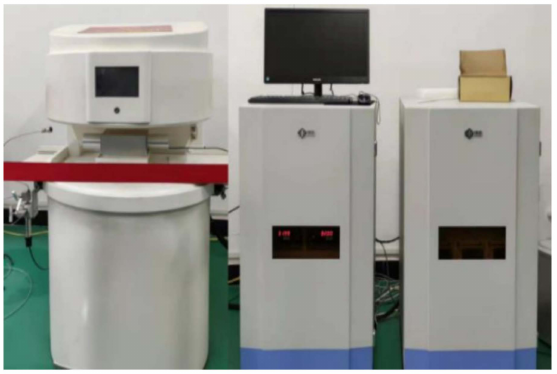
Figure 3. MESOMR 23-060H-I NMR